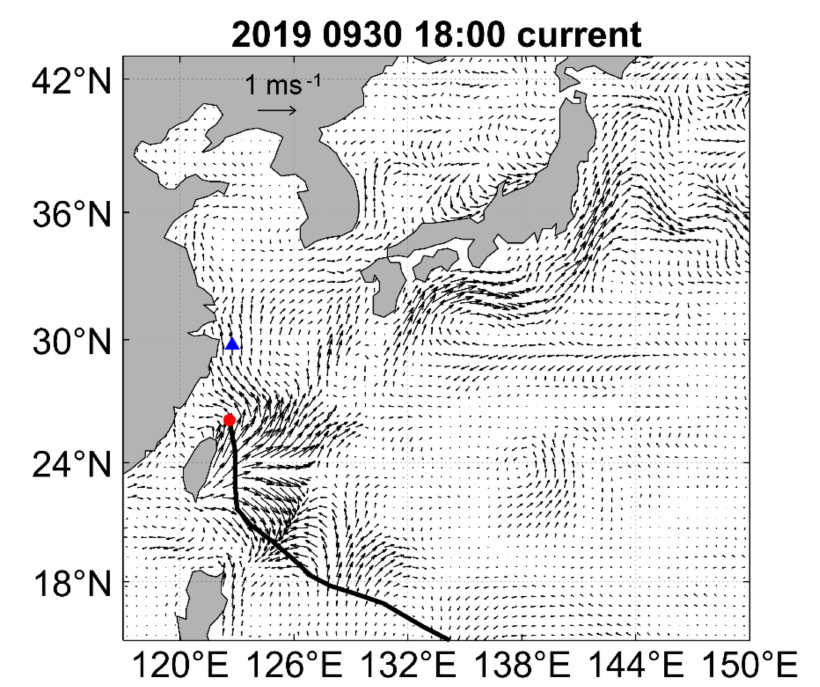
Figure 9. The sea surface current field at 18:00 on 30 September. (The vectors represent currents, the black line is “MITAG” track, the red circle is typhoon center, and the blue triangle is location of Zhoushan buoy.)